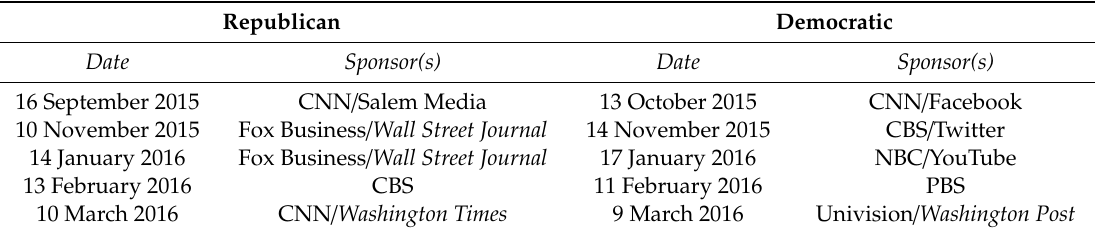
Table 1. Debates included in the